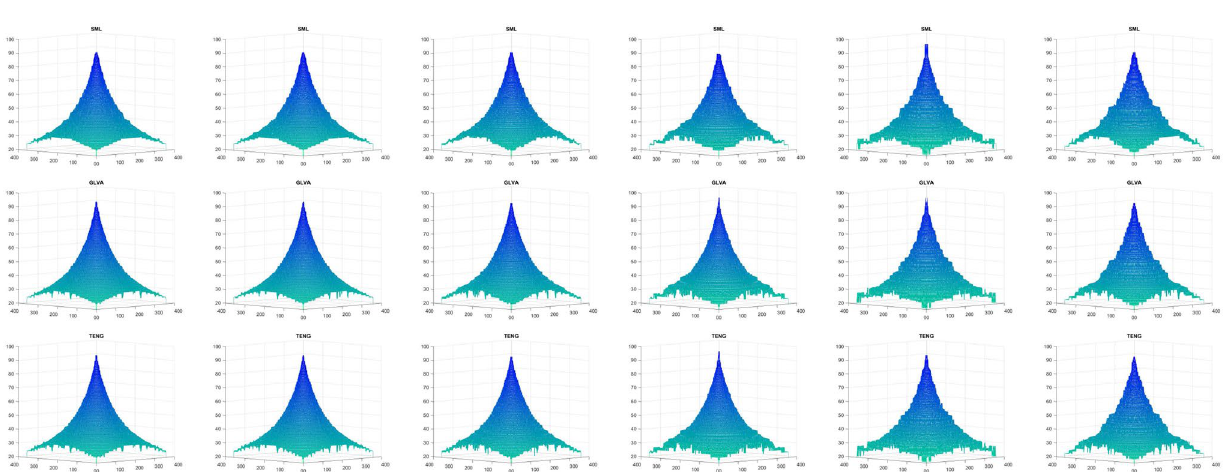
Figure 8. Average of Depth Distortion Metrics for different FMs for Jitter noise σ 2 ξ 2 . σ 2 with 0 ζ ≤ ≤